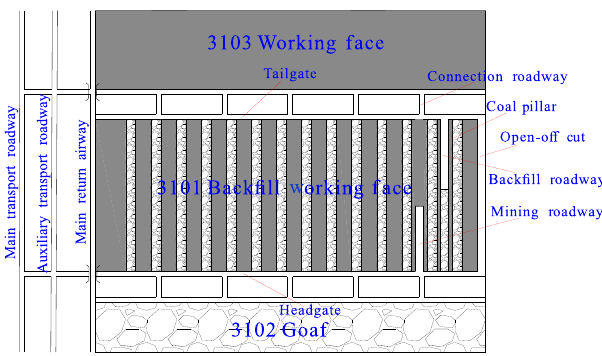
Figure 14. Layout of the mining system used in the Changxing coal